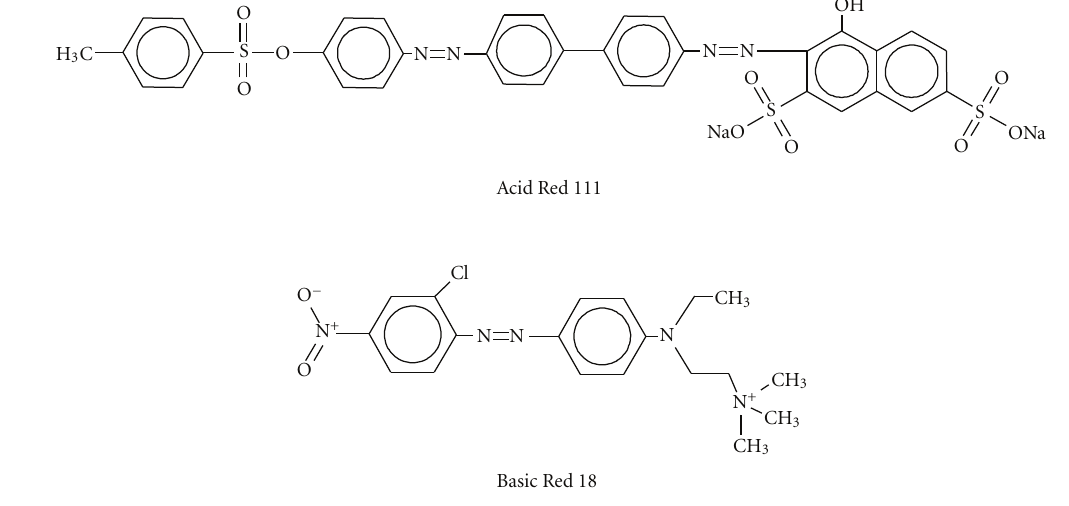
F 1: Chemical structure of investigated dyes. T 1: Properties of